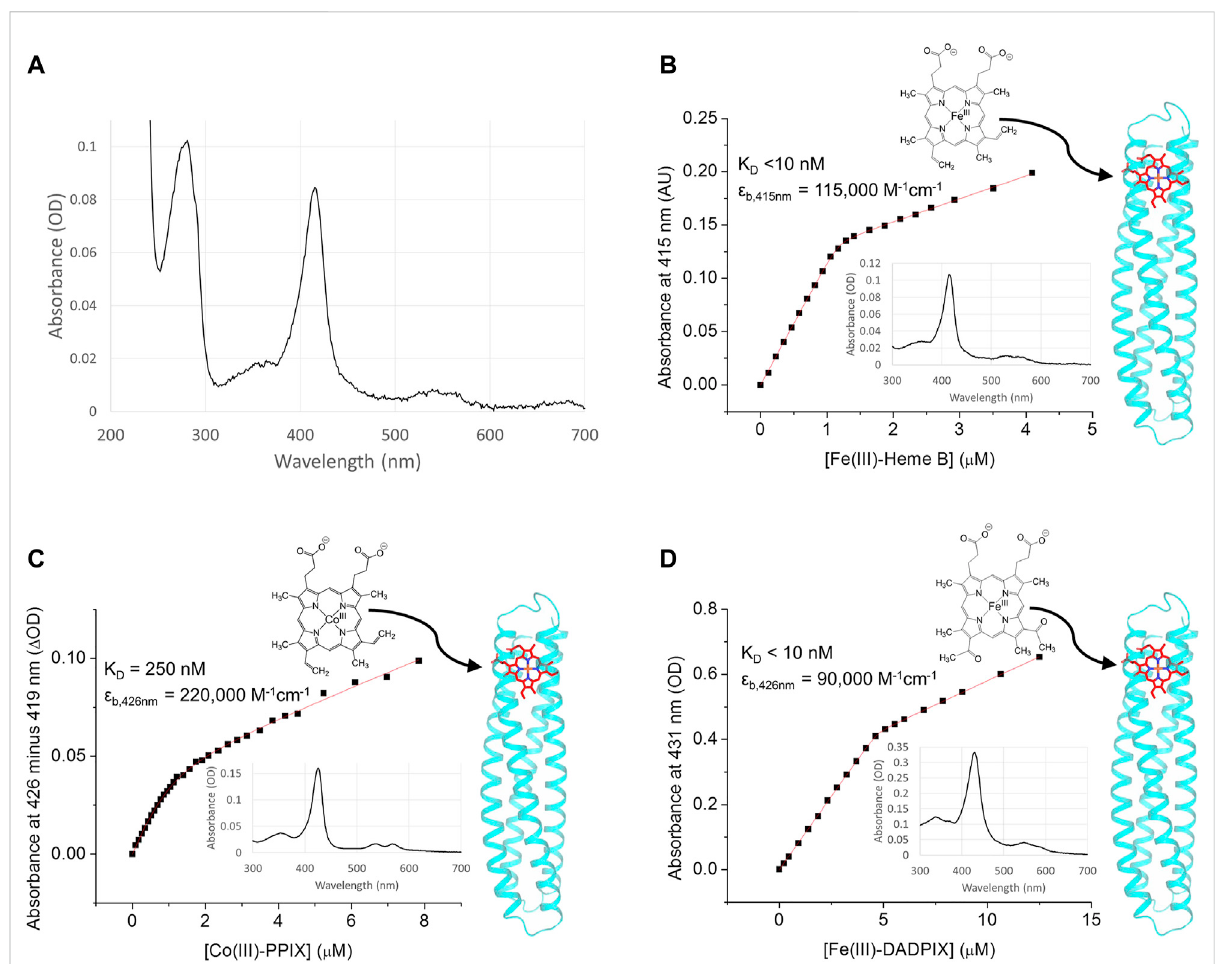
FIGURE 3 RC maquette electron acceptor binding. (A) Spectrum of puri fi ed RC maquette without addition of exogenous heme reveals that ~10% of proteinretained hemefrom expression in E. coli after proteinpuri fi cation.Inpanels (B – D) ,absorbance isplotted against cofactorconcentration and fi t to a one-site binding equation (Eq. 2). The structure of each acceptor is shown, and arrows indicate thelikely binding location in the RC maquette on the right. Inset are absorbance spectra after the addition of 0.8 molar equivalents of cofactor. (B) Binding of Fe(III)-heme B to 1.2 µM RC maquette in 15 mM NaCl and 10 mM sodium phosphate buffer at pH 7.0. (C) Binding of Co(III)-PPIX to 1.1 µM RC maquette in 50 mM NaCl and 10 mM MOPS buffer at pH 7.0. (D) Binding of Fe(III)-DADPIX to 4.4 µM RC maquette in 50 mM NaCl and 20 mM sodium phosphate buffer at pH